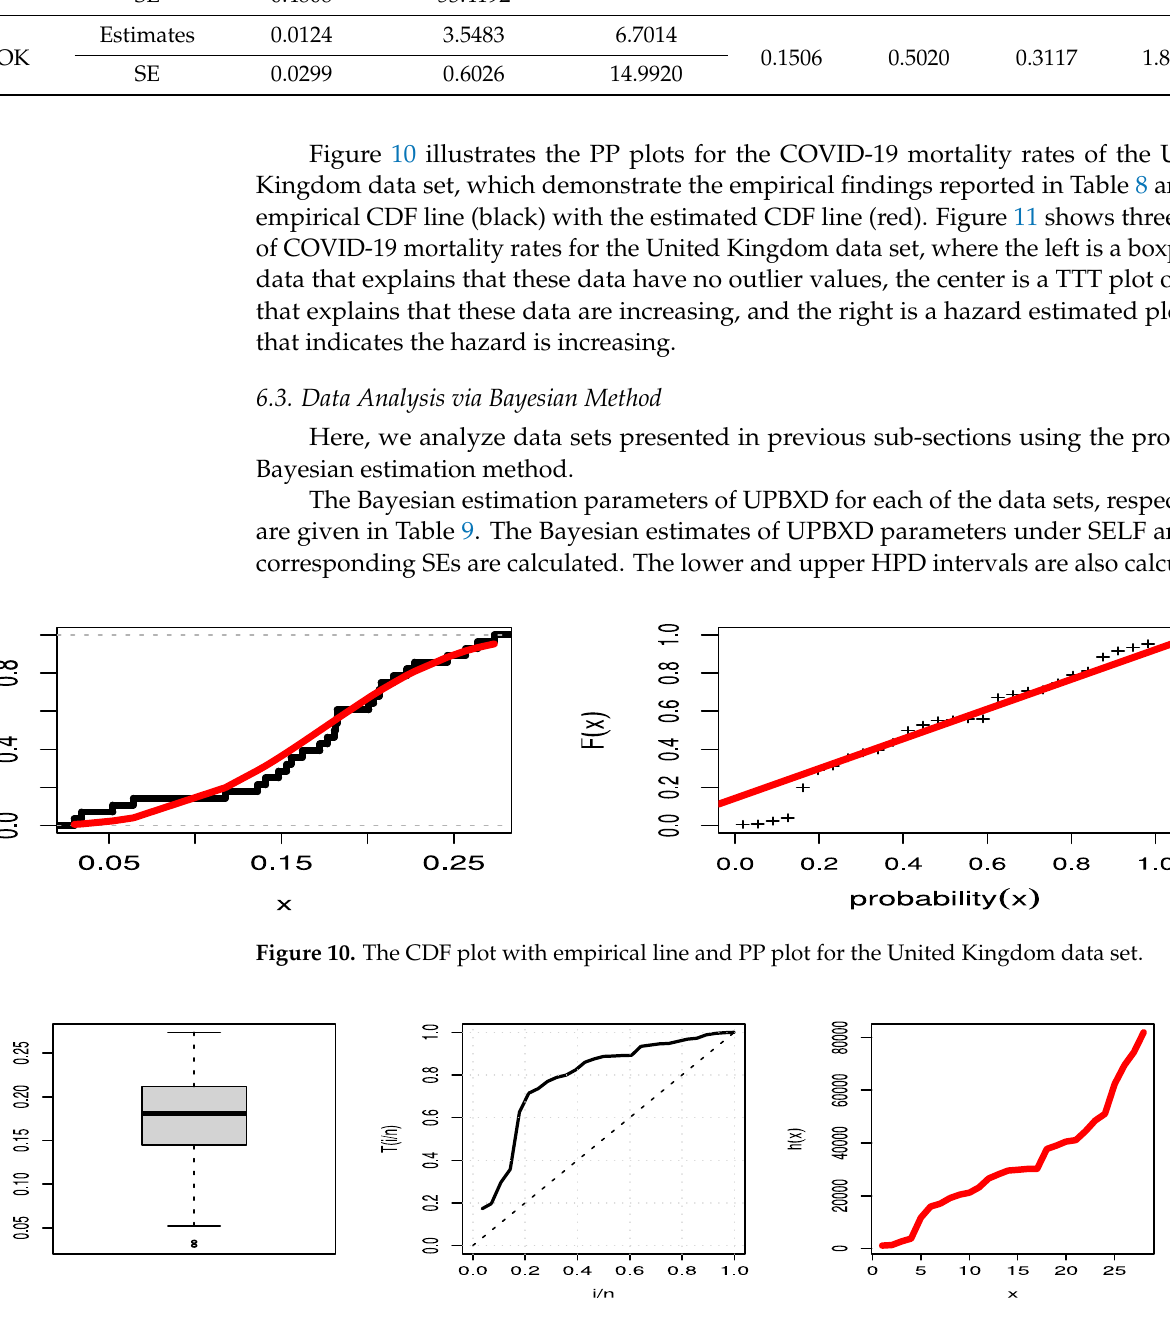
Figure 11. Boxplot, TTT plots and hazard line of UPBXD plot for the United Kingdom data